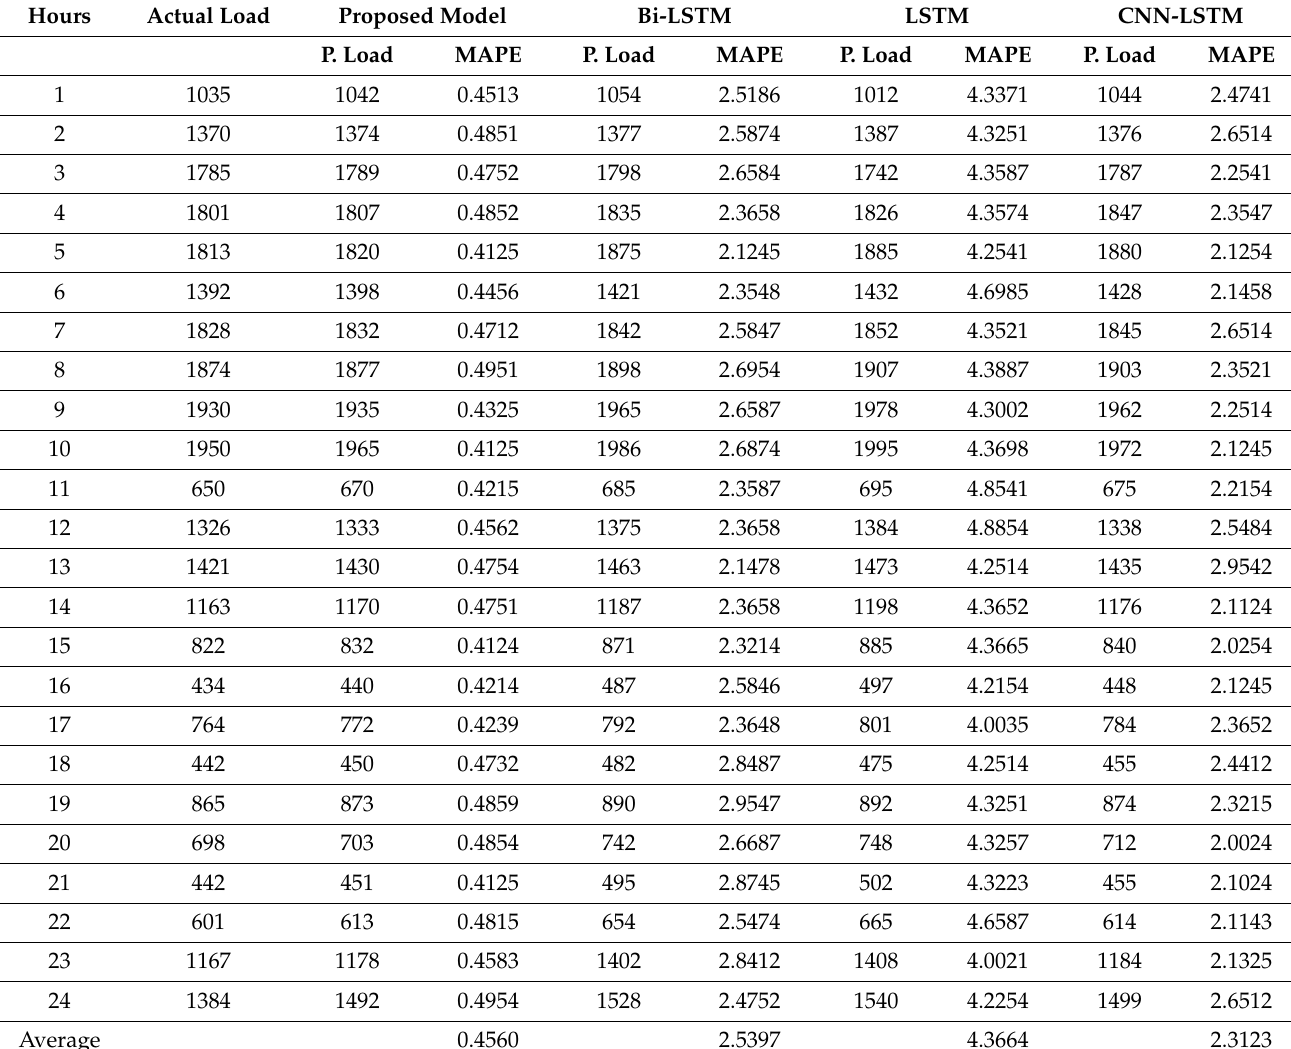
Table 3. Comparison of proposed model with other state of the art algorithms using mean absolute percentage